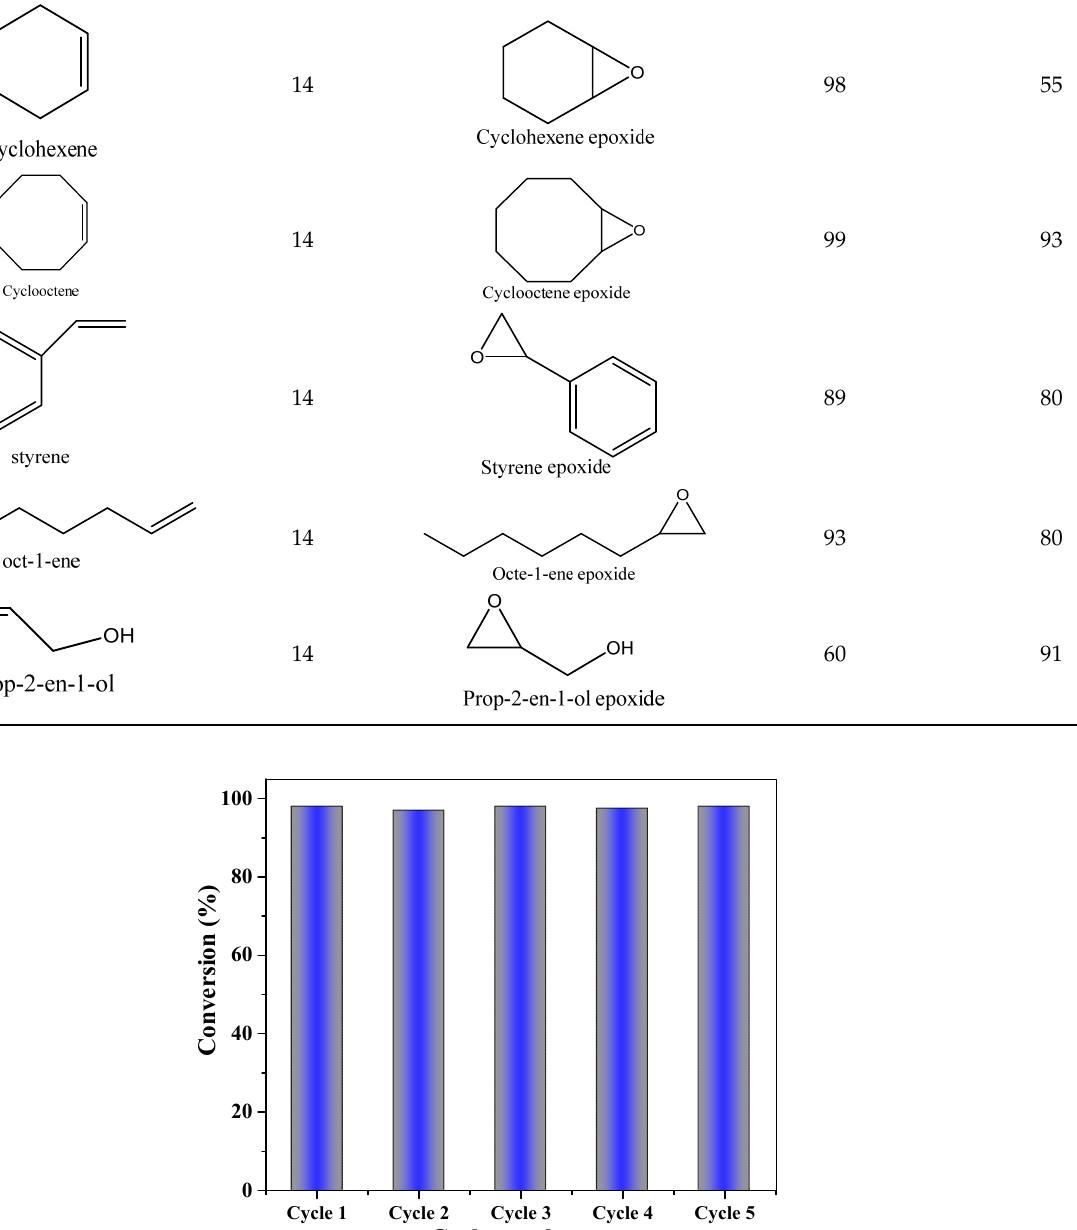
Table 3. Catalytic activity of various heterogeneous catalysts in cyclohexene epoxidation.